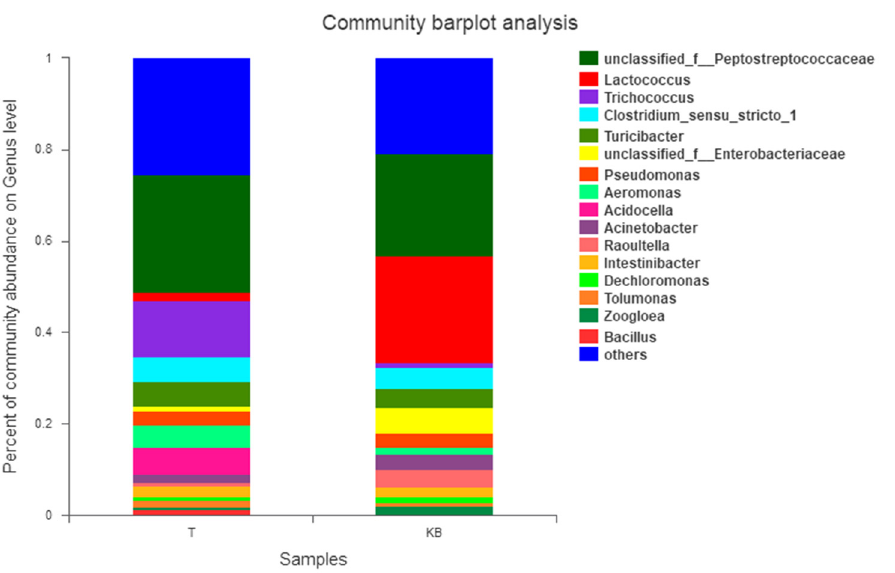
Figure 3. Bacterial community structure of bistriazine ring derivative wastewater and blank control wastewater.